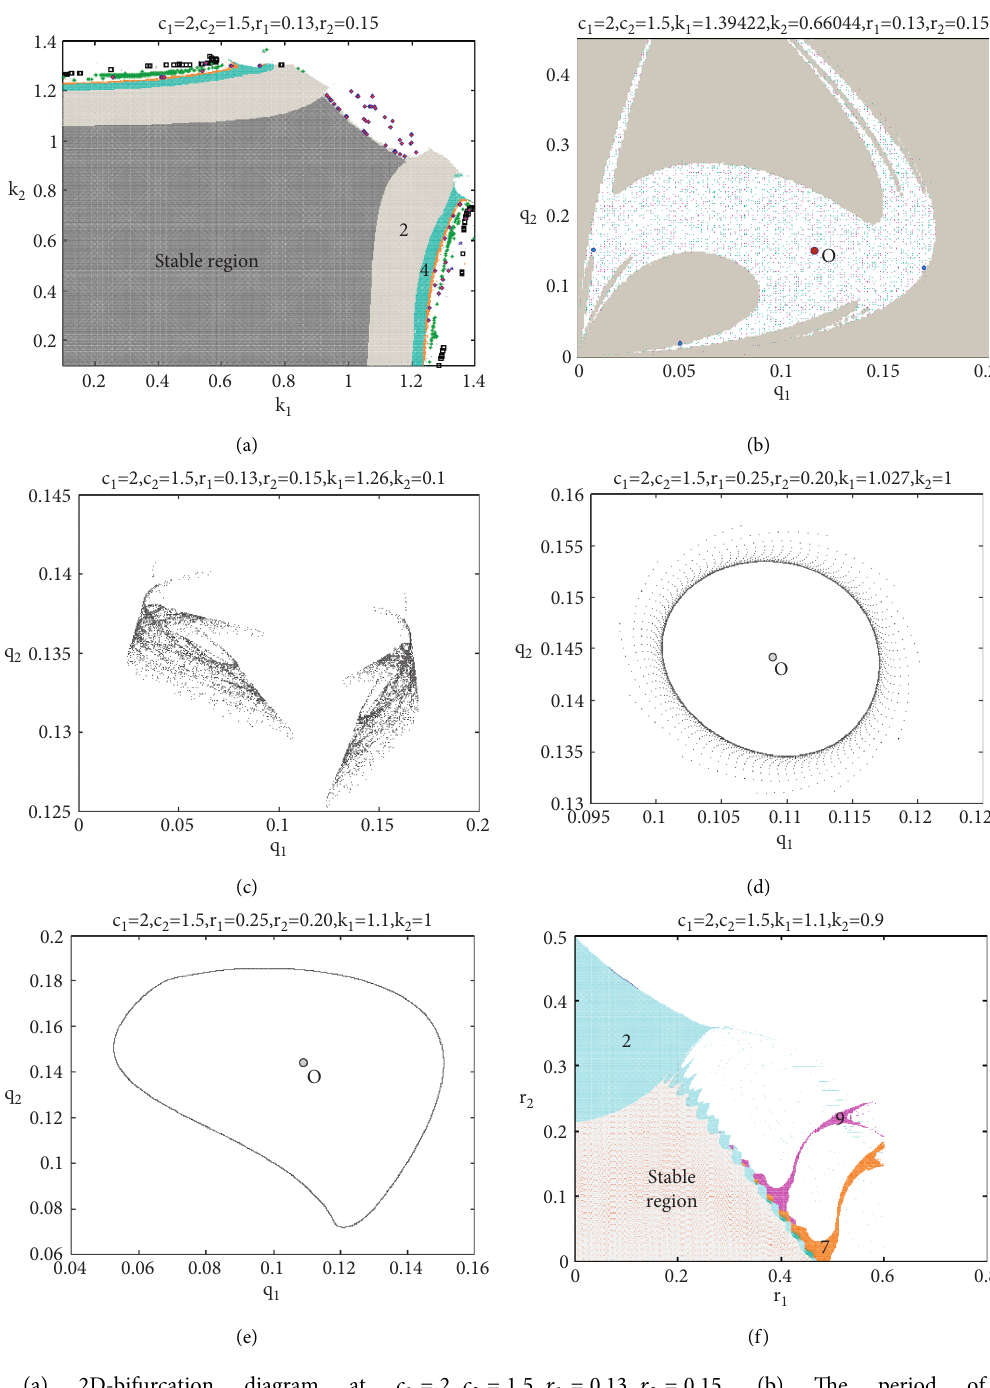
3: (a) 2D-bifurcation diagram at (b) The period of 3-cycle at � 2 , c � 1 . 5 ,r � 0 . 13 ,r � 0 . 15 ,k � 1 . 39422, and k � 0 . 66044. (c) Chaotic dynamic behavior at c � 2 , c � 1 . 5 , r � 0 . 13 , c 1 2 1 2 1 2 1 2 1 r � 0 . 15 , k � 1 . 26 , k � 0 . 1. (d) Closed invariant curve at c � 2 , c � 1 . 5 , r � 0 . 25 , r � 0 . 20 , k � 1 . 027 , k � 0 . 1. (e) Closed ring at 2 1 2 1 2 1 2 1 2 � 2 , c � 1 . 5 , r � 0 . 25 , r � 0 . 20 , k � 1 . 1 , k � 0 . 1. (f) 2D-bifurcation diagram at c � 2 , c � 1 . 5 , k � 1 . 1 , k � 0 . c 1 2 1 2 1 2 1 2 1 2 2.5. Critical Curves and Preimage Zones. The phase plane of